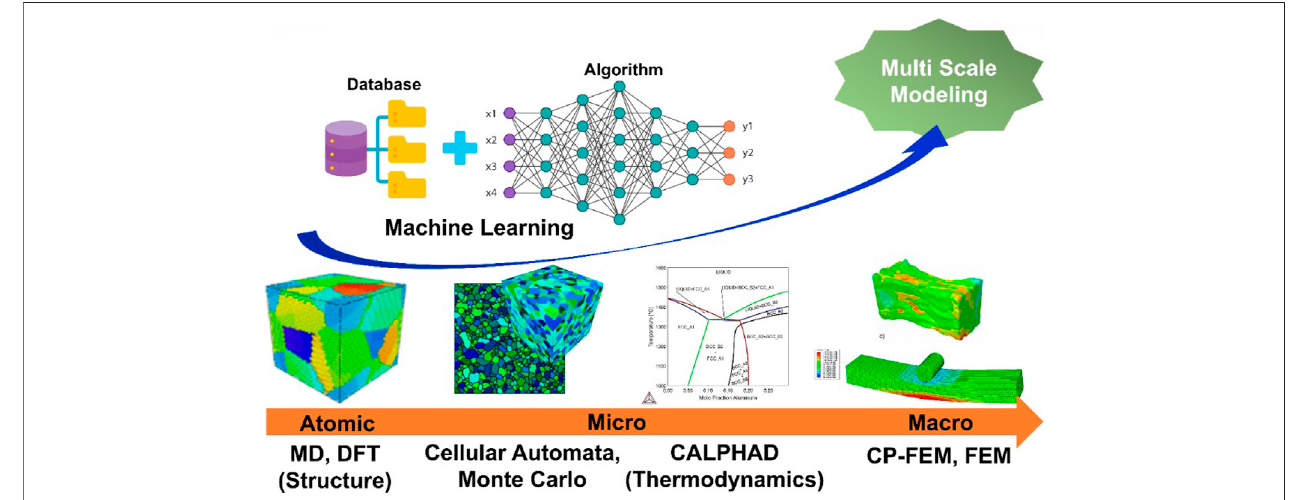
FIGURE 1 | The schematic fl ow chart of multi-scale